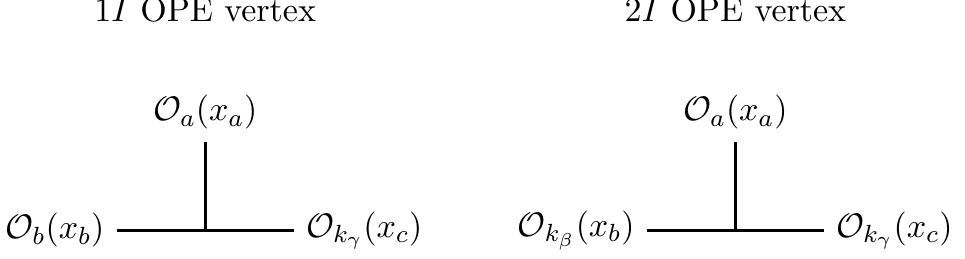
) represent external (internal, or exchanged) a